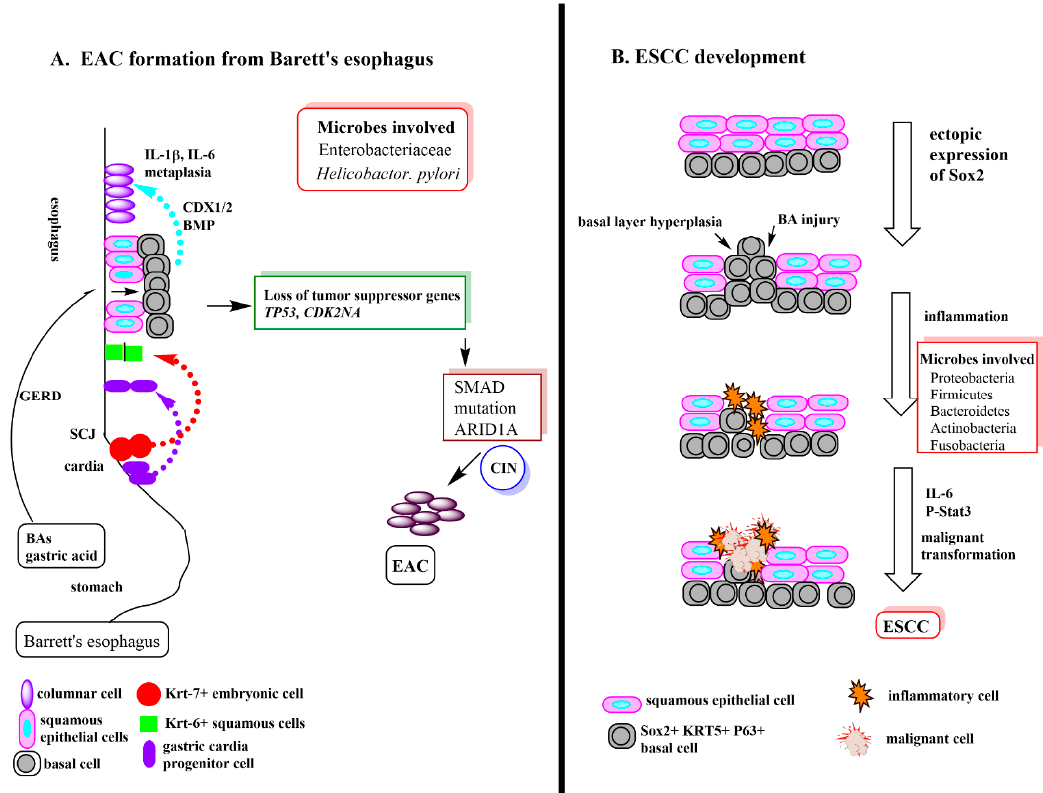
Figure 2. ( A ) The formation of Barrett’s esophagus and transition to esophageal adenocarcinoma. There are several popular theories as to how Barrett’s esophagus is formed. The three most current are pictured diagrammatically in this figure. (1) The purple arrow indicates the migration of gastric cardia progenitor cells to the esophagus due to inflammation driven expansion of these cells. (2) The red arrow indicates the inflammation driven migration of Krt-7+ squamous epithelial cells at the SCJ junction to replace the normal Krt-6+ in the esophagus. (3) The blue arrow indicates what happens after GERD damage opens up squamous cell junctions and allow acid damage of the basal cells. In response to damage the basal cells express CDX1 and BMP to cause the basal cells to transform into metaplastic columnar cells along with further increased damage due to inflammation. Once Barrett’s esophagus is established, further inflammation induced damage of the co- lumnar cells leads to cell mutations, notably, loss of tumor suppressor genes, TP53 and CDK2NA which in turn, increases mutation of SMAD (leads to dysregulated cell growth) and the expression of AT-rich interactive domain-containing pro- tein 1A, ARID1A) (part of a protein complex responsible for activating genes normally silenced by chromatin structure). The final result is chromosome instability (CIN) and malignant transformation to EAC [19]. Abbreviations: AT-rich inter- active domain-containing protein 1A (ARID1A), bile acid (BA), bone morphogenetic protein (BMP, growth factor), caudal homeobox gene 1 (CDX1), chromosomal instability (CIN), cyclin-dependent kinase inhibitor 2A (CDKN2A, tumor sup- pressor), esophageal adenocarcinoma (EAC), gastric acid esophageal reflux disease (GERD), interleukin (IL) (IL-1 β , IL-6, inflammatory cytokines), squamocolumnar junction (SCJ), tumor protein 54 (TP53, tumor suppressor) ( B ) ESCC develop- ment . The development of esophageal squamous cell carcinoma (ESCC) begins with the ectopic expression of Sox2 in basal cells. Sox2 is critical for maintaining self-renewal and appropriate proportion of basal cells in adult tracheal epithelium. However, its overexpression gives rise to extensive epithelial hyperplasia. BA injury to basal cells leads to more basal cell hyperplasia and inflammation. Increased levels of the inflammatory cytokine, IL-6, and increased levels of activated P- Stat3 results in malignant transformation to ESCC. Abbreviations: Signal transducer and activator of transcription 3 (STAT3), SRY (sex determining region Y)-box 2 (Sox2) Reference for microbiota involvement [15].